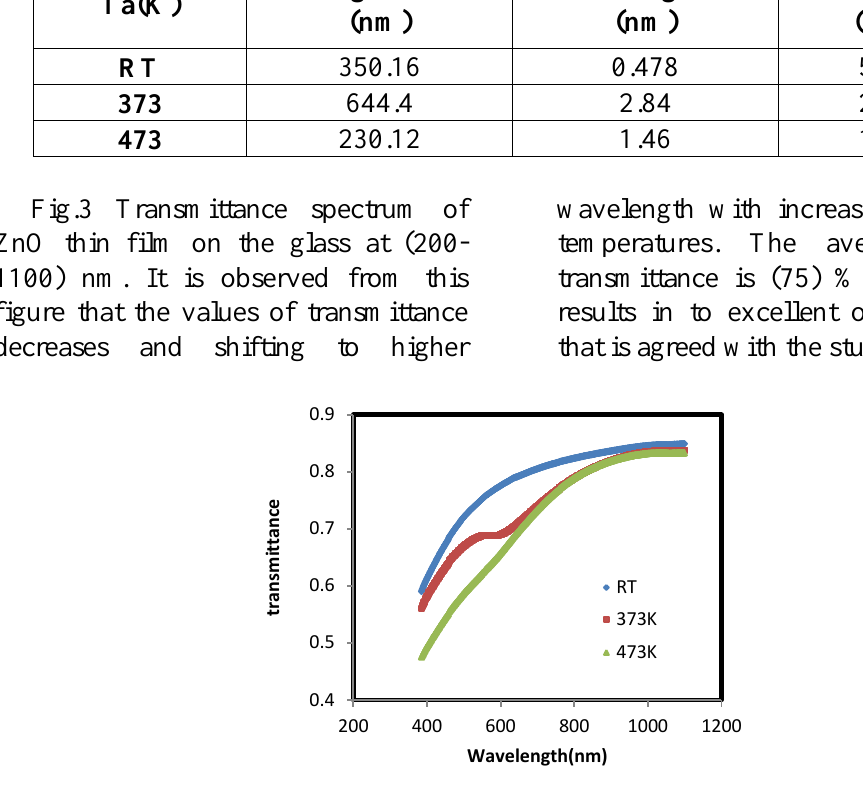
Fig.3: Transmittance spectrum of ZnO thin films at different annealing temperatures (as deposited, 373, 473)